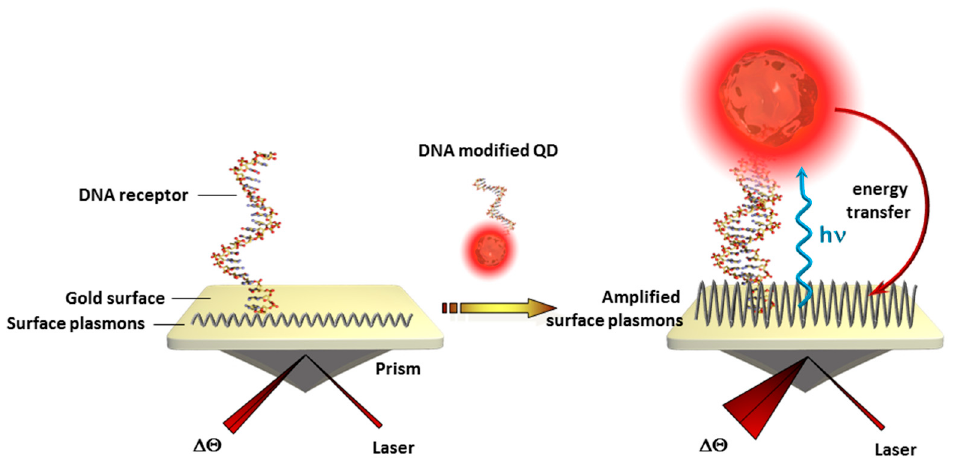
Figure 4. Schematic illustration of SPR signal amplification after the biorecognition event using QD labeled biomarkers.